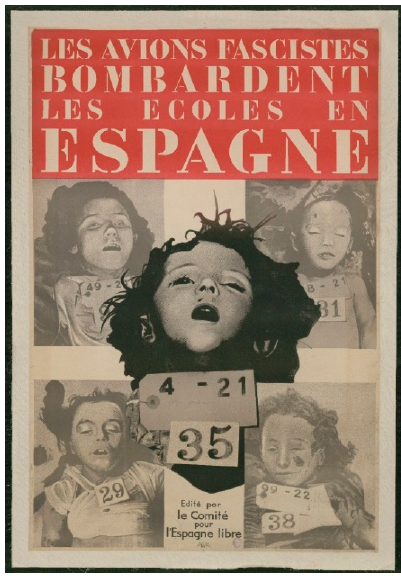
Figure 16. “Schools in Spain.” Photograph, ink on paper. La Contemporaine. AFF24125 (4).